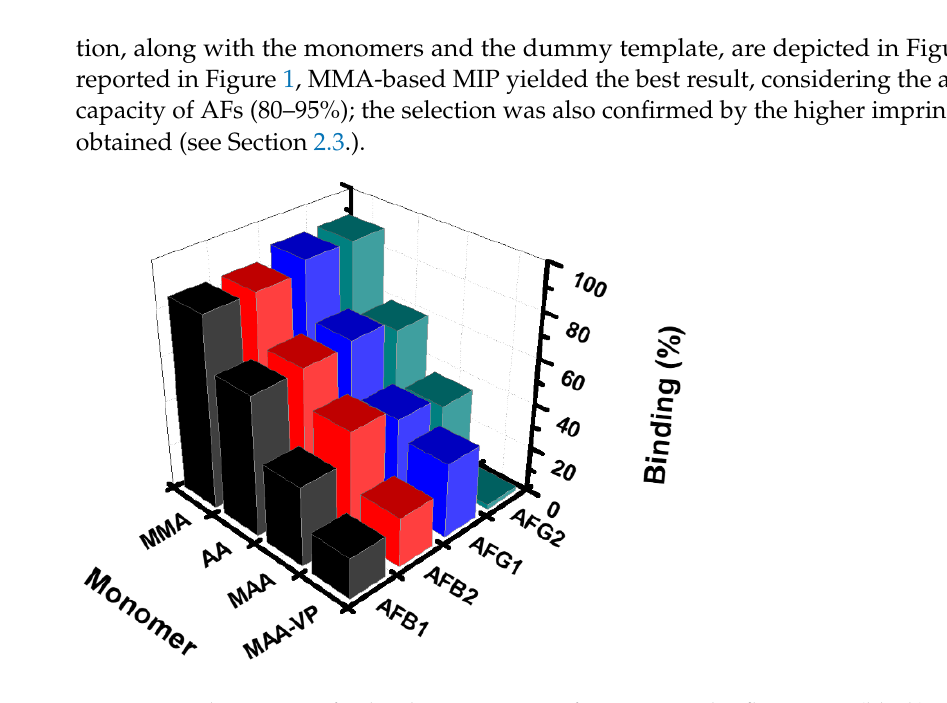
Figure 1. 3D histogram of % binding capacities of MIPs towards aflatoxin B1 (black), aflatoxin B2 (red), aflatoxin G1 (blue), aflatoxin G2 (green) at a concentration of 5 µ g/mL. MIPs were synthetized with different monomers: methacrylamide (MMA), acrylamide (AA), methacrylic acid (MAA), and methacrylic acid +2-vinylpyridine (MAA-VP).